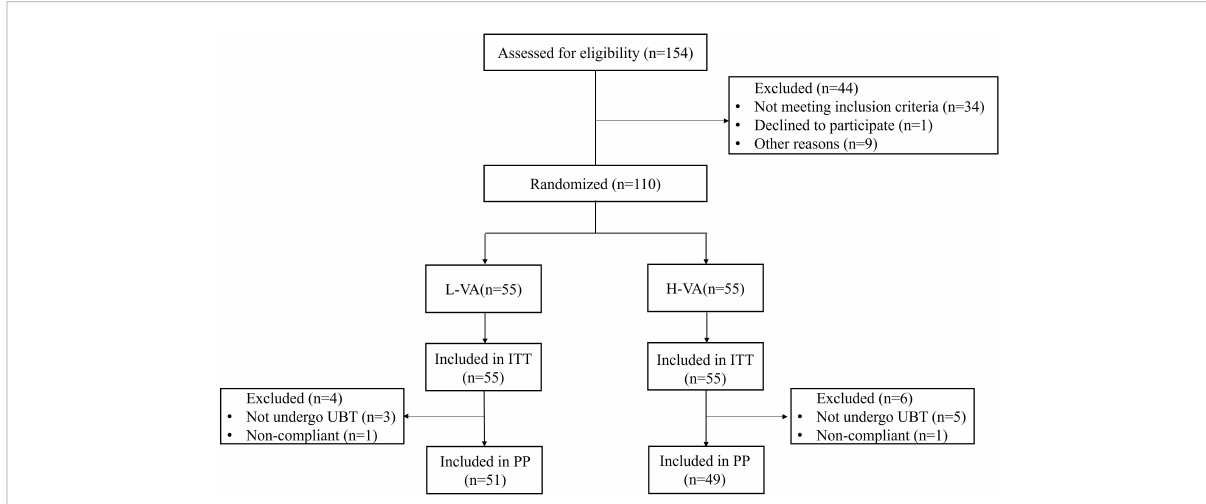
FIGURE 1 Flow chart of patient enrollment. ITT, intention to treat; PP, per protocol; L-VA, dual therapy consisting of low-dose amoxicillin (1000 mg b.i.d.) and vonoprazan (20 mg b.i.d.); H-VA, dual therapy consisting of high-dose amoxicillin (1000 mg t.i.d.) and vonoprazan (20 mg